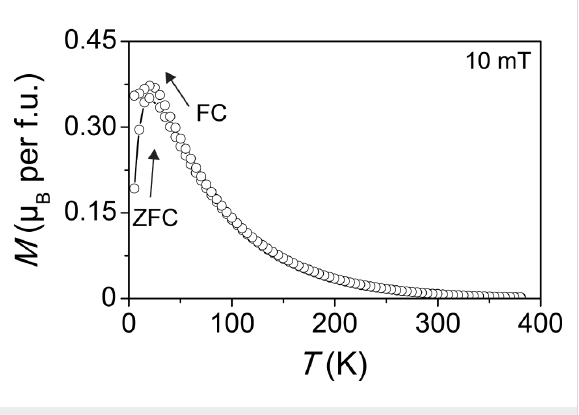
Figure 5: Direct-current SQUID magnetometry of as-prepared ZFO nanoparticles. ZFC/FC curves measured with µ 0 H DC = 10